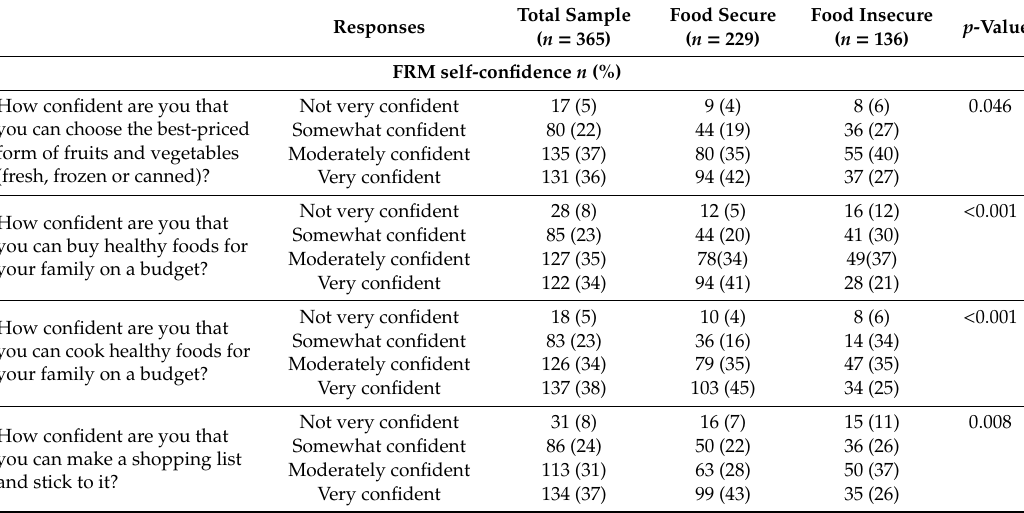
Table 2. Food resource management (FRM) self-confidence and FRM behaviors of Head Start caregivers in the study sample by household food insecurity, ( n = 365) 1